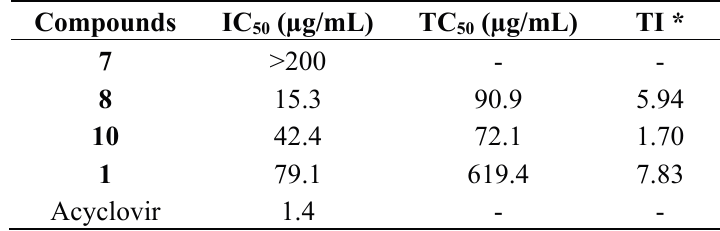
Table 1. TC 50 and IC 50 values of compounds against